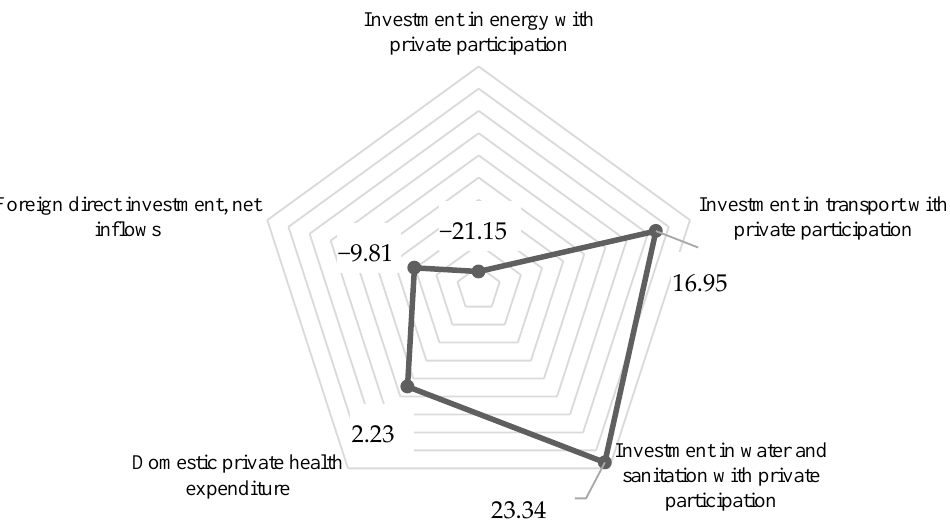
Figure 4. Correlation between commercial and responsible investments in 2020 and return on assets of companies in 2021, %. Source: authors.